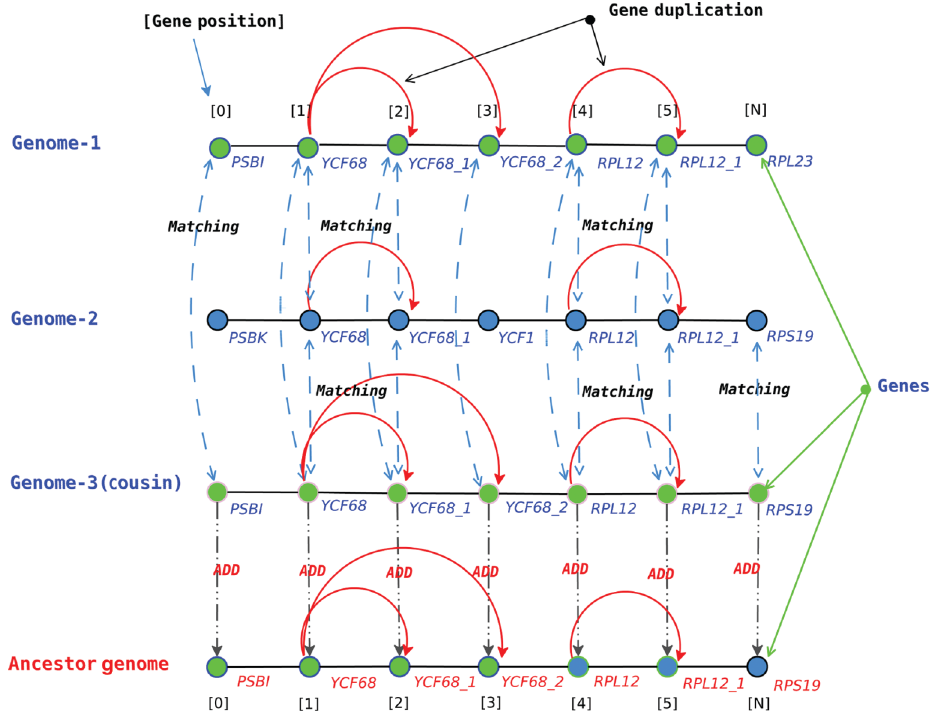
Figure 2: Simulation of ancestral reconstruction process between two genomes. ADD means that the considered sequence has been added to the list of genes in the ancestral